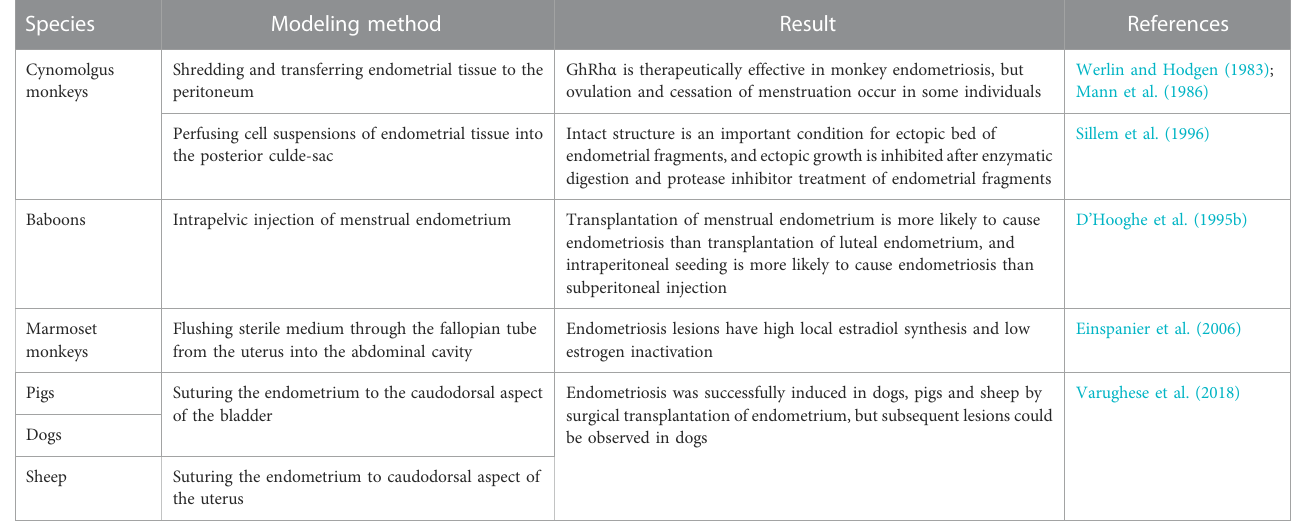
TABLE 4 Large animal models for the study of